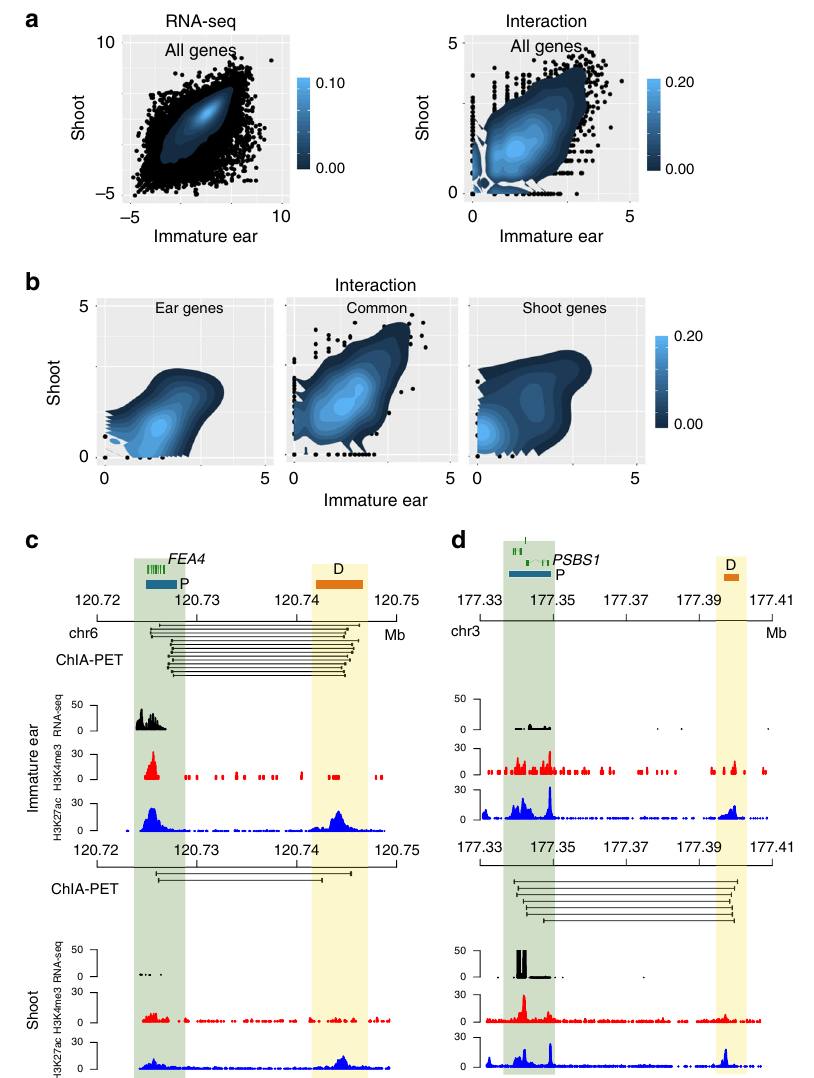
Fig. 6 Tissue-speci fi c chromatin interactions in immature ear and shoot. a The heat map of fragments per kilobase of transcript per million (FPKM) value (left panel) and chromatin interaction (right panel) of all genes in immature ear and shoot. b The heat map of chromatin interactions of immature ear- speci fi c expressed genes ( p = 0.006, two-sided t test), common genes, and shoot-speci fi c expressed genes ( p = 0.002, two-sided t test) in immature ear and shoot, respectively. c An example of immature ear-speci fi c chromatin interaction. FEA4 gene (highlighted in dark green) interacted with a distantly located ( ∼ 17 kb) distal PET peaks (D) (highlighted in yellow) in immature ear. In contrast, the FEA4 gene in shoot was not expressed and had no interaction with that D. d An example of shoot-speci fi c chromatin interaction. PSBS1 gene (highlighted in dark green) interacted with a distantly located ( ∼ 58 kb) D (highlighted in yellow) in shoot. In contrast, the PSBS1 gene in immature ear was not expressed and had no interaction with that D. The green rectangle represents the corresponding gene. The blue and orange rectangles indicate P and D,